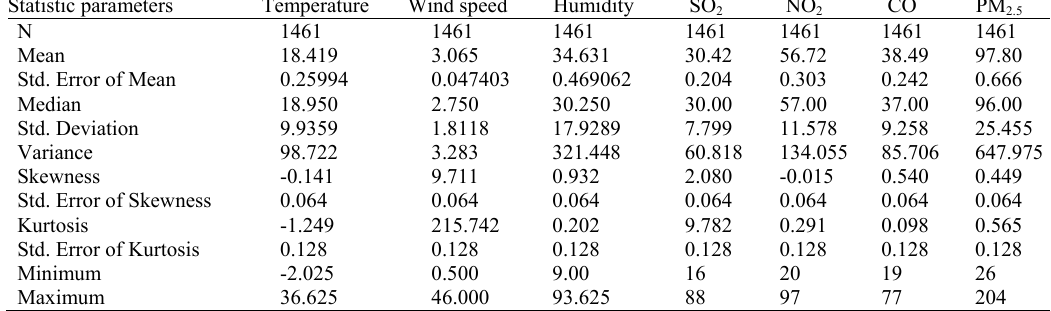
Table 1: The descriptive statistics of daily air pollutants and meteorological parameters as input data (from 21 March 2011 to 20 March 2015) Statistic